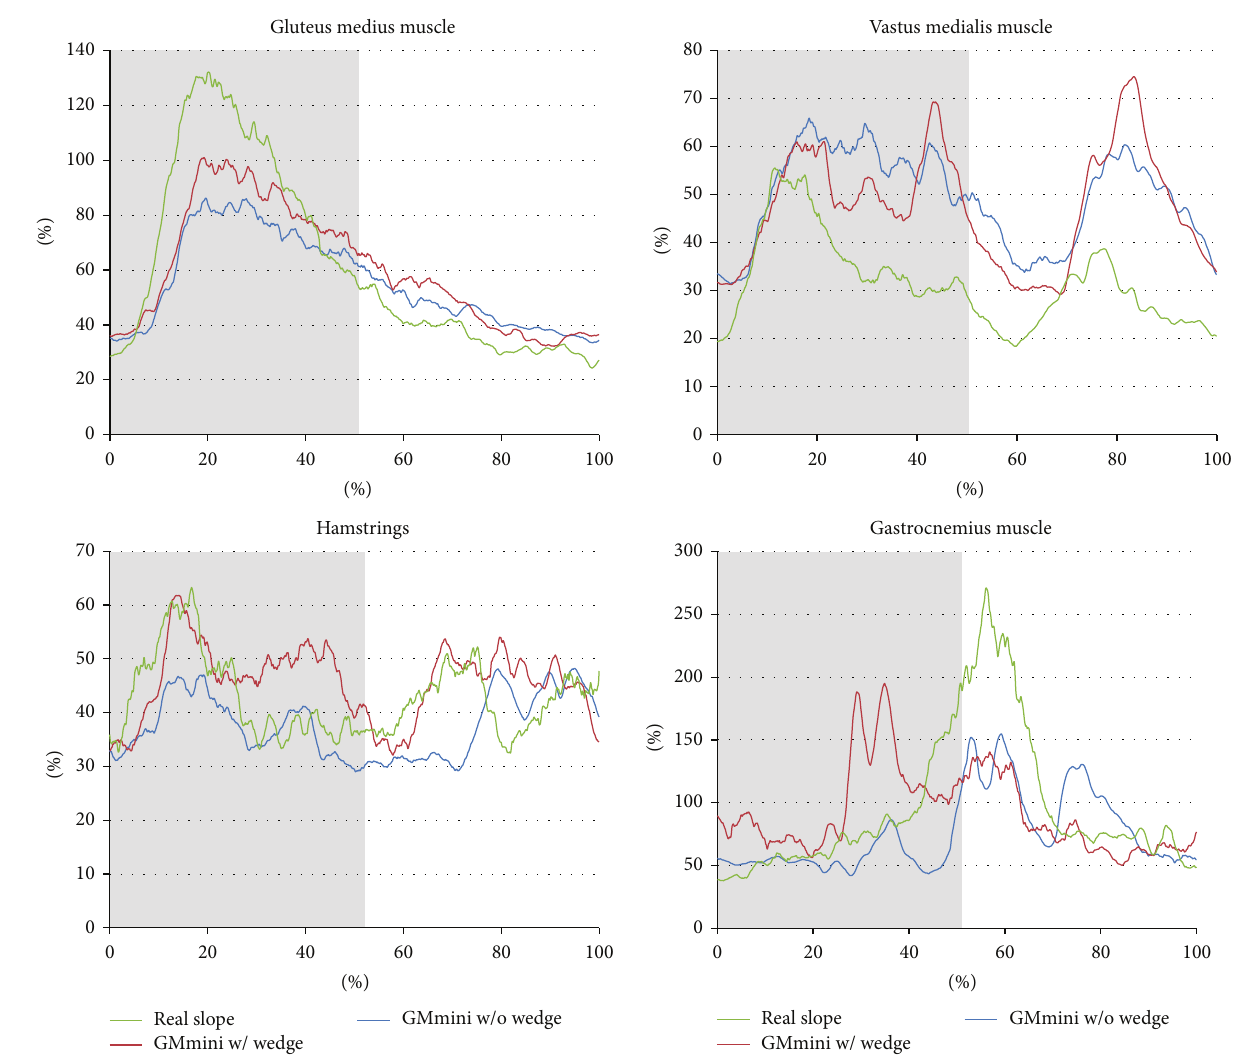
Figure 15: Time series variation of the average RMS values of the EMGs during ascent of a 15-degree incline.